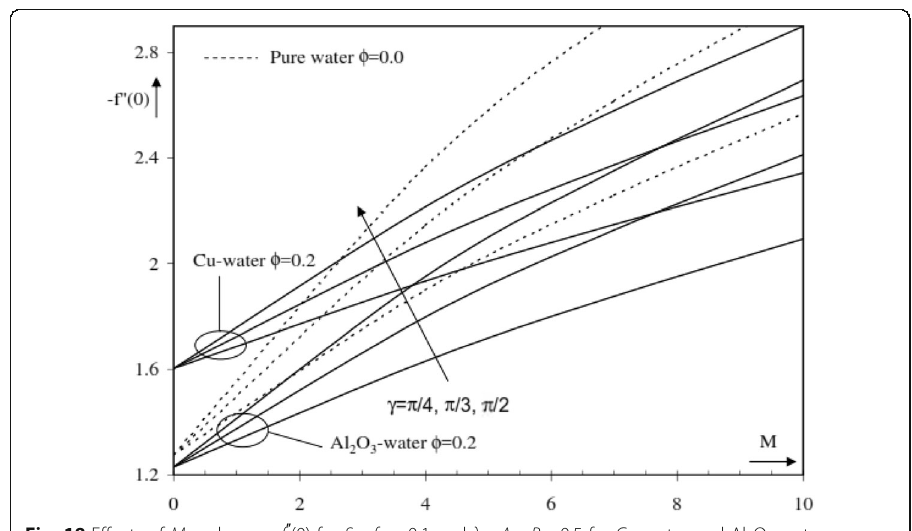
Fig. 18 Effects of M and γ on − f ″ (0) for S = f w = 0.1 and λ = A = B = 0.5 for Cu-water and Al 2 O 3